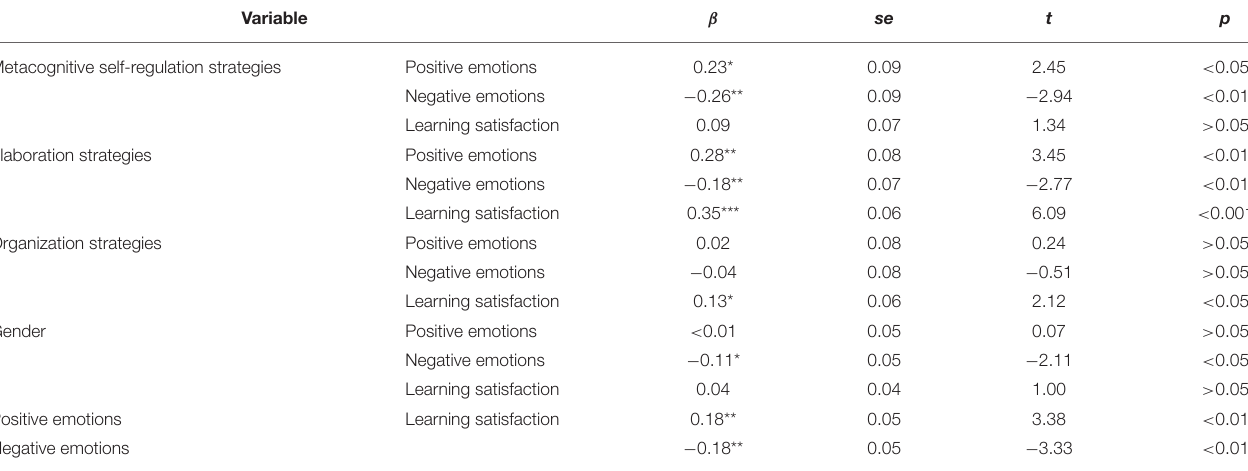
TABLE 3 | Path coefficients of the initial structural model.